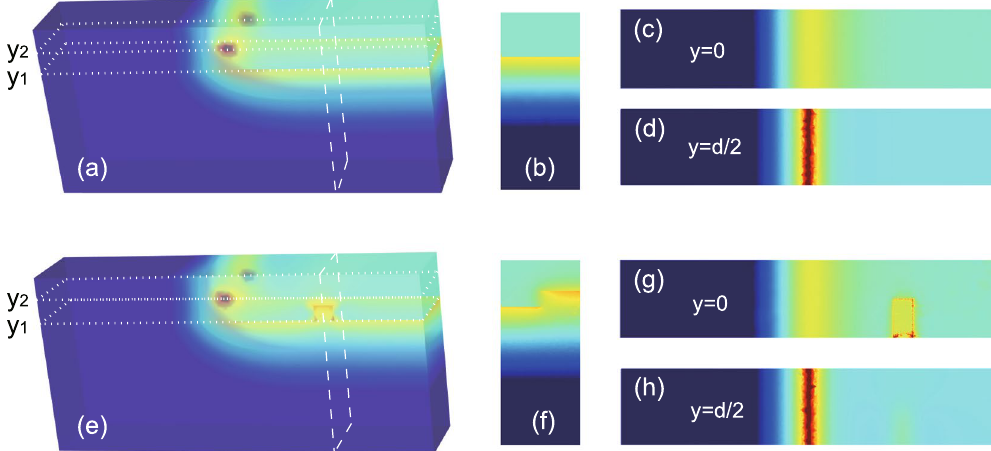
Figure 2. Simulated magnetic field amplitudes for the 3D guiding systems without ( a ) and with ( e ) obstacle. The obstacle in ( e ) is a square YIG column with a side length of 1 mm and it lies on the half of the YIG surface. ( b ) Vertical cutting slice in ( a) at 30 mm away from the source, ( c ) and ( d ) are the horizontal cutting slices in ( a ) at y 1 = 0 and y 2 = d /2, respectively. ( f – h ) Three corresponding slices in ( e ). The operation frequency is f = 5.6 GHz, and the parameters of the guiding system are the same as in Fig.